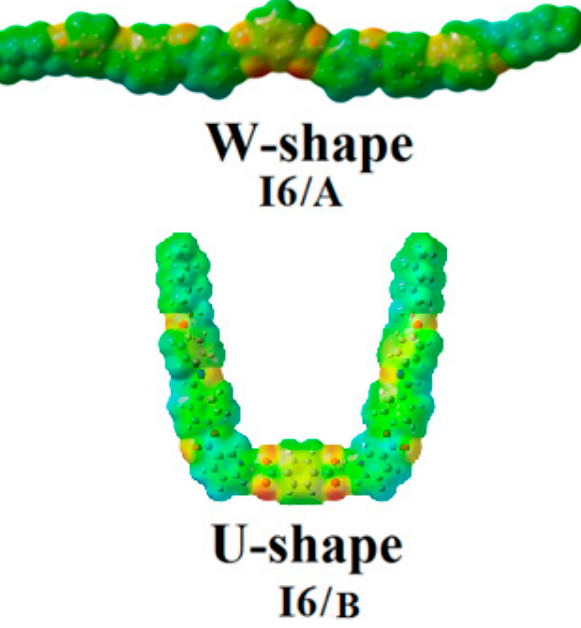
Figure 6. Molecular electrostatic potentials (MEPs) for the I6/A and I6/B SMHBCs.